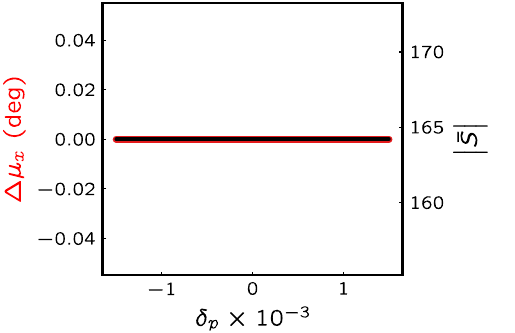
FIG. 8. Comparison of tune sweep (Standard) and COSE momentum function at the 400 GeV = c SPS flat-top. With COSE the required momentum function evolution follows the momen- tum distribution of the beam.